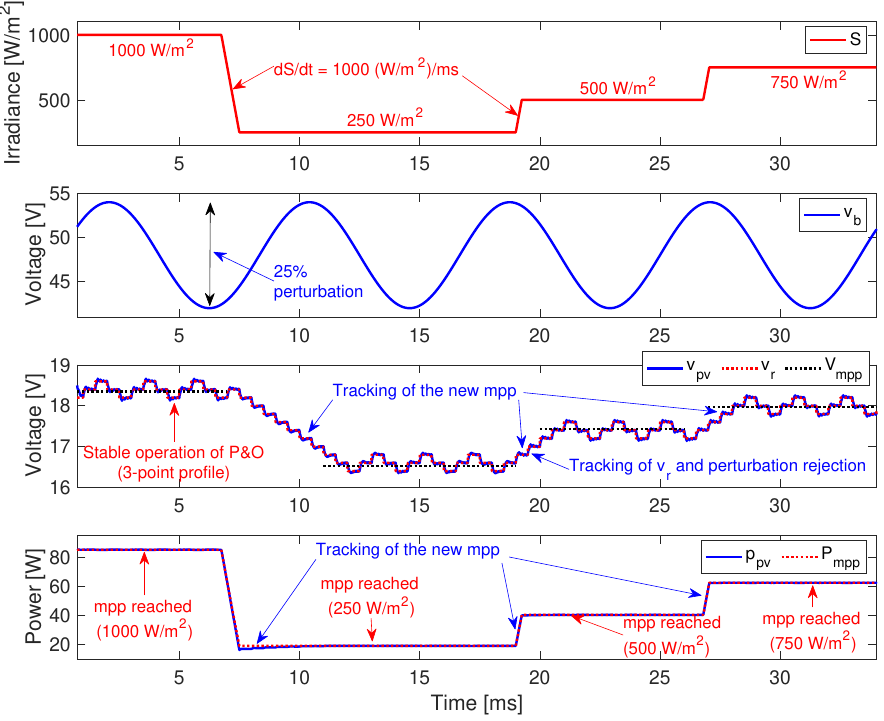
Figure 18. Complete PV system operation under changing irradiance